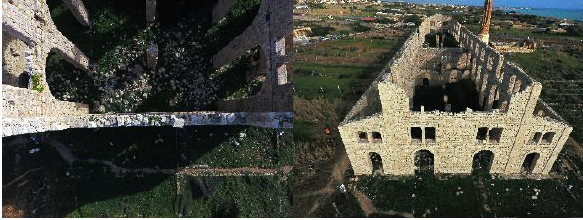
Figure 6. Image examples: nadir (left) and 45° oblique (right).